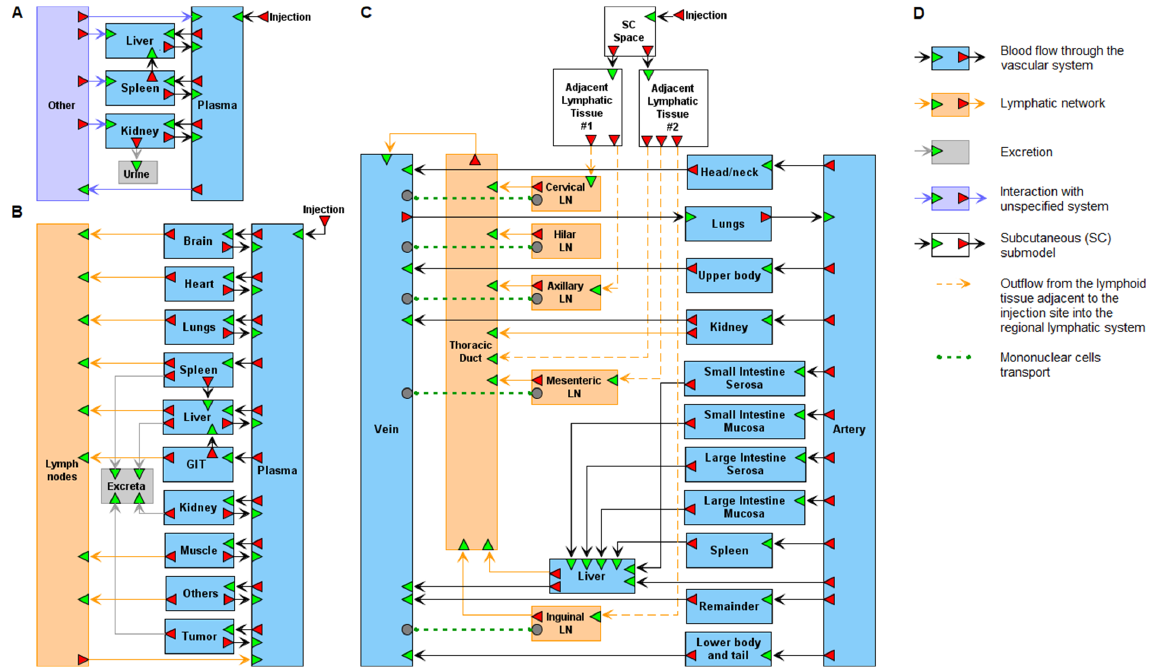
Figure 2. Different in complexity structures of physiologically based pharmacokinetic (PBPK) models of nanoparticle (NP) delivery. ( A ) The model [53] describing the biodistribution of fluorescently labeled NPs in mice used for the controlled delivery of dexamethasone in acute lymphoblastic leukemia therapy. A possible explanation of the “other” compartment (included in the model to fit the simulation results with the experimental data) is the lymphatic system or the adsorption of NPs to the endothelial walls of blood vessels. ( B ) The model of Dogra et al. [54] of whole-body NP pharmacokinetics and their tumor delivery in rats. GIT denotes gastrointestinal tract. ( C ) The model [56] evaluating the systemic and lymphatic pharmacokinetics of 3 HIV drugs, lopinavir, ritonavir, and tenofovir, coformulated in drug-combination NPs (DcNPs). DcNPs administered as a series of subcutaneous (SC) subinjections in the upper back of nonhuman primates are taken up by adjacent lymphoid tissues and then released into the lymphatic system. In regional lymph nodes (LNs), a part of the DcNPs is taken up by mononuclear cells (MCs), while the rest enters the thoracic duct and moves to the bloodstream. Lymphatic recirculation occurs through the organs containing the mononuclear phagocytic system (kidney, spleen, liver). The green dotted lines denote exchange of DcNPs between LN MCs and peripheral blood MCs migrated into the proximity of individual LNs. ( D ) Graphical notation used to visualize the models in the BioUML software, (v. 2022.1, Biosoft.ru, Ltd., Novosibirsk,